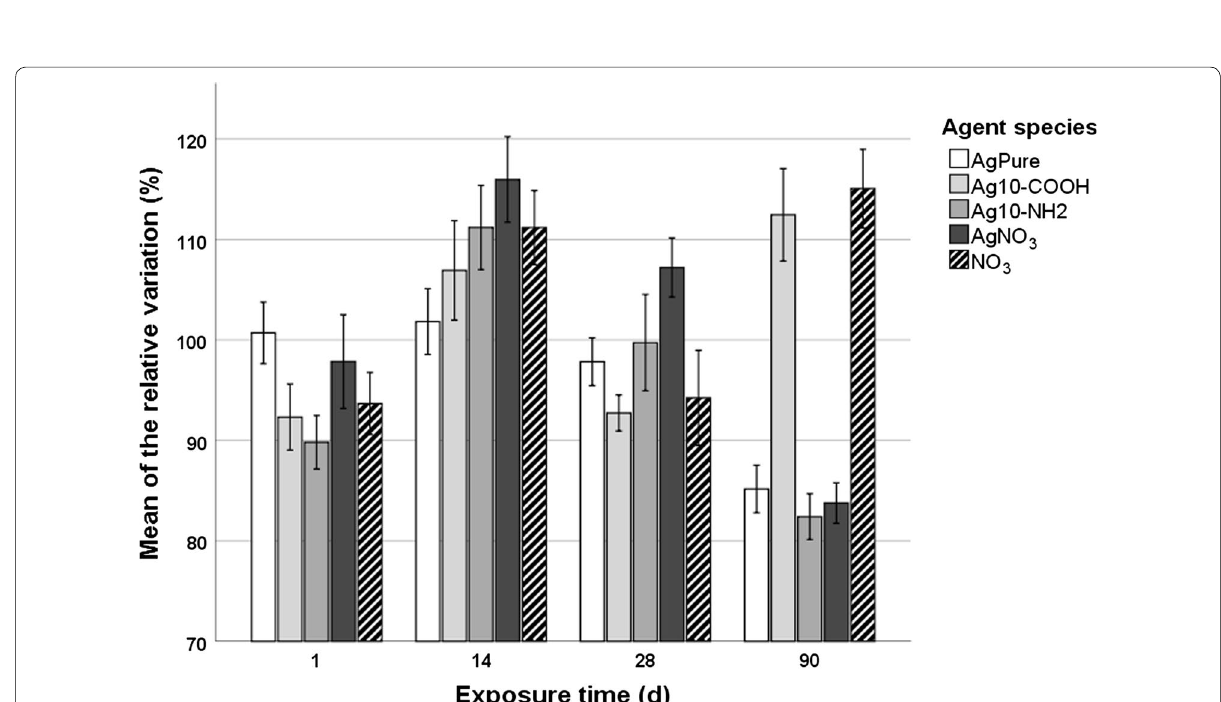
Fig. 5 Impact of the factors exposure time ( a ) and agent species ( b ) in a loamy soil. The error bars represent the 95% confidence interval. N The relative variations (%) were set as dependent variable. The factors were set as independent variable. To calculate the effect of the exposure time on the relative variation of the biological parameters, the relative variations were calculated unconnected to the factors concentration and agent species ( a ). For the calculation of the effect expression of the factor agent species , the relative variations were unconnected to the factors concentration and exposure time ( b )